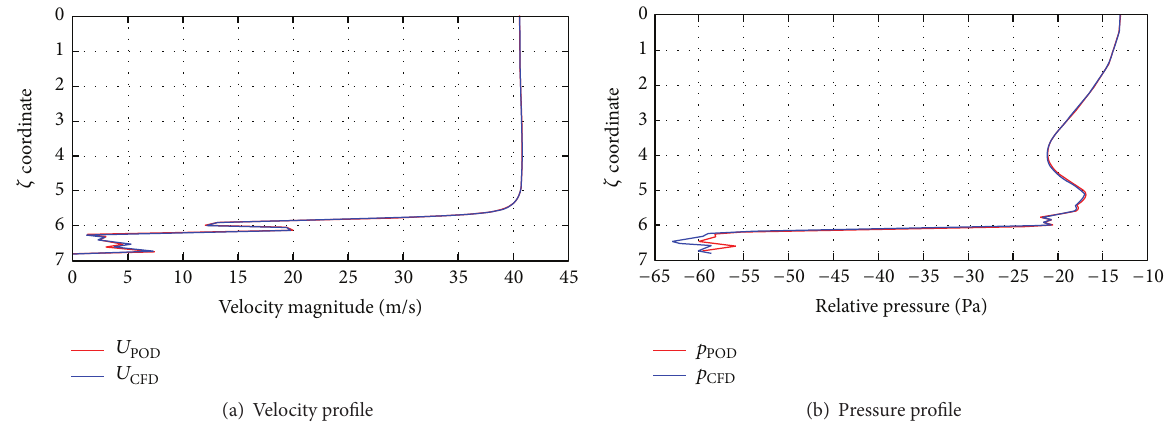
Figure 22: DrivAer model. Velocity and pressure profiles in the wake section.